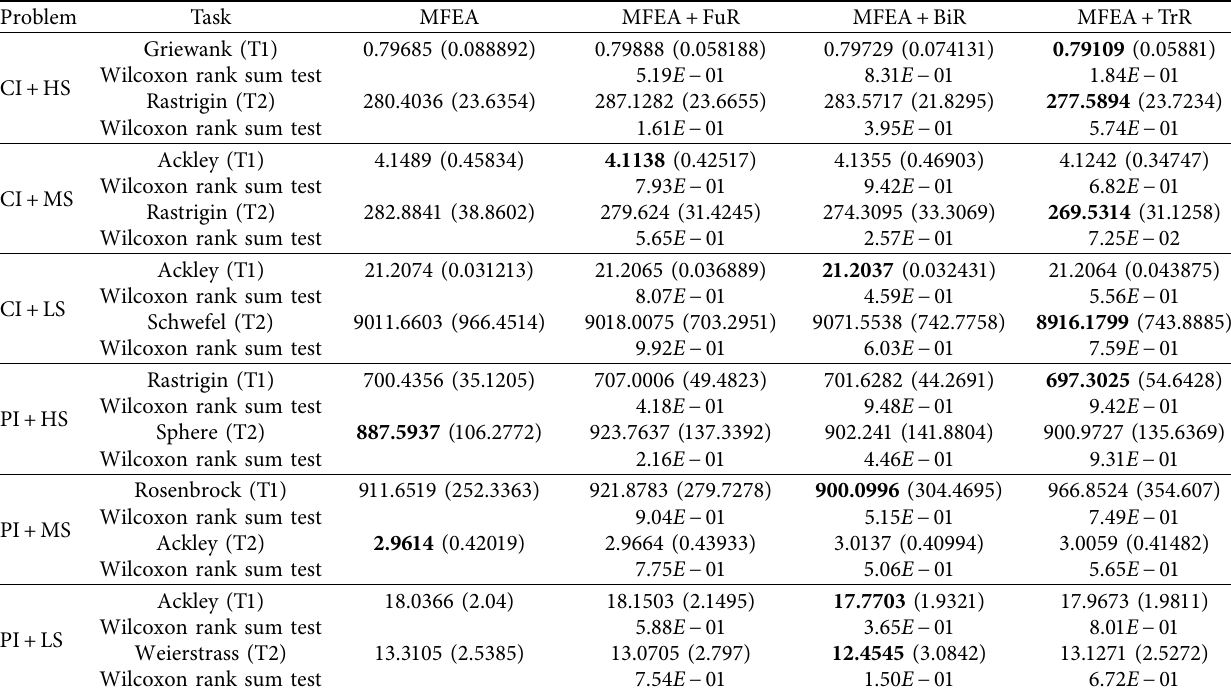
Table 2: Results obtained by MFEA under different order of